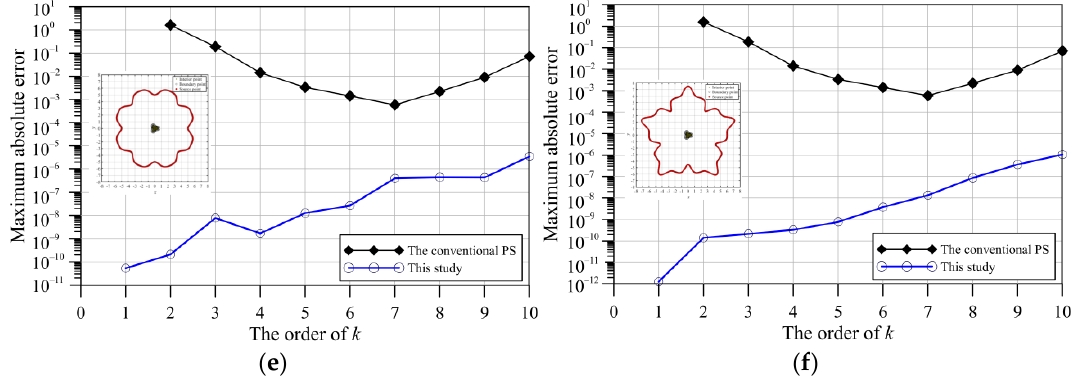
Figure 3. The computed MAE values for the original PRBF and the proposed PRBF with fictitious sources: ( a ) Case I; ( b ) Case II; ( c ) Case III; ( d ) Case IV; ( e ) Case V; ( f ) Case VI. Table 1. A comparison of the results.